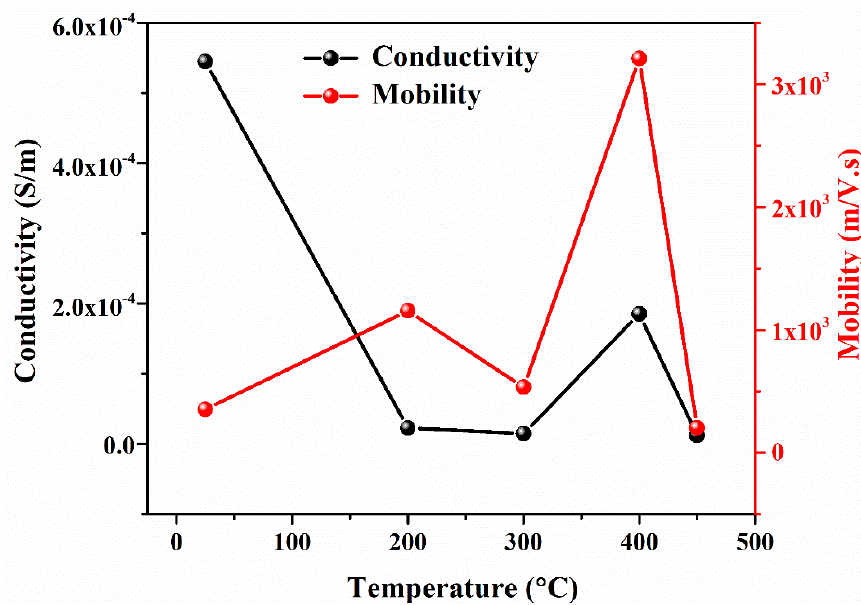
Figure 7. Conductivity and Mobility of PbS at 25 °C, 200 °C, 300 °C, 400 °C, and 450 °C. Sheet resistance, also known as surface resistivity, is the resistance measured across the surface of two-dimensional thin film, when the electrodes made contact with the sur- face of the film [37]. The distance between contacts has no effect on sheet resistance; there- fore, it is extensively used to compare the electrical properties of the devices made by different films [38].